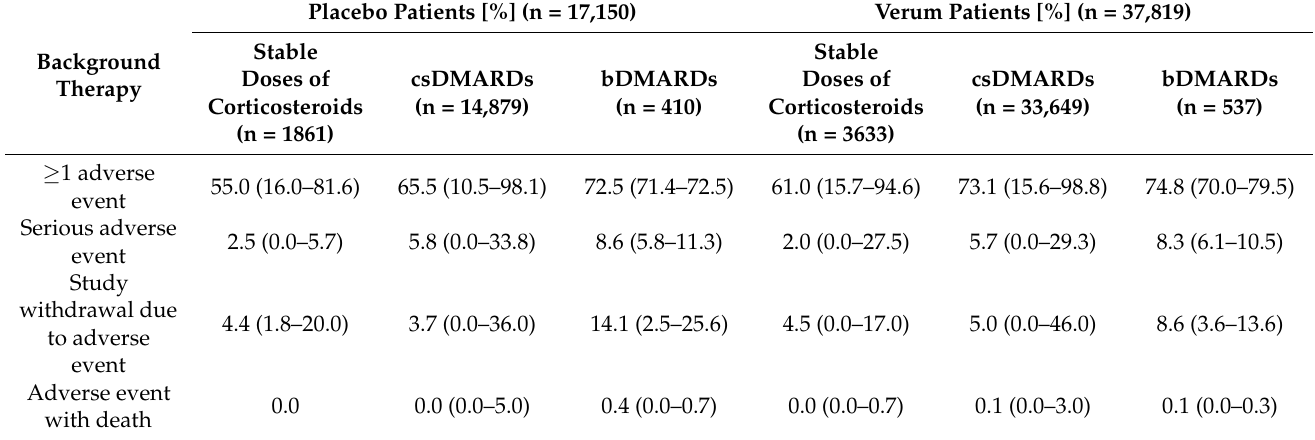
Table 2. Summary of adverse events in percentages of placebo patients compared to verum-treated patients depending on background